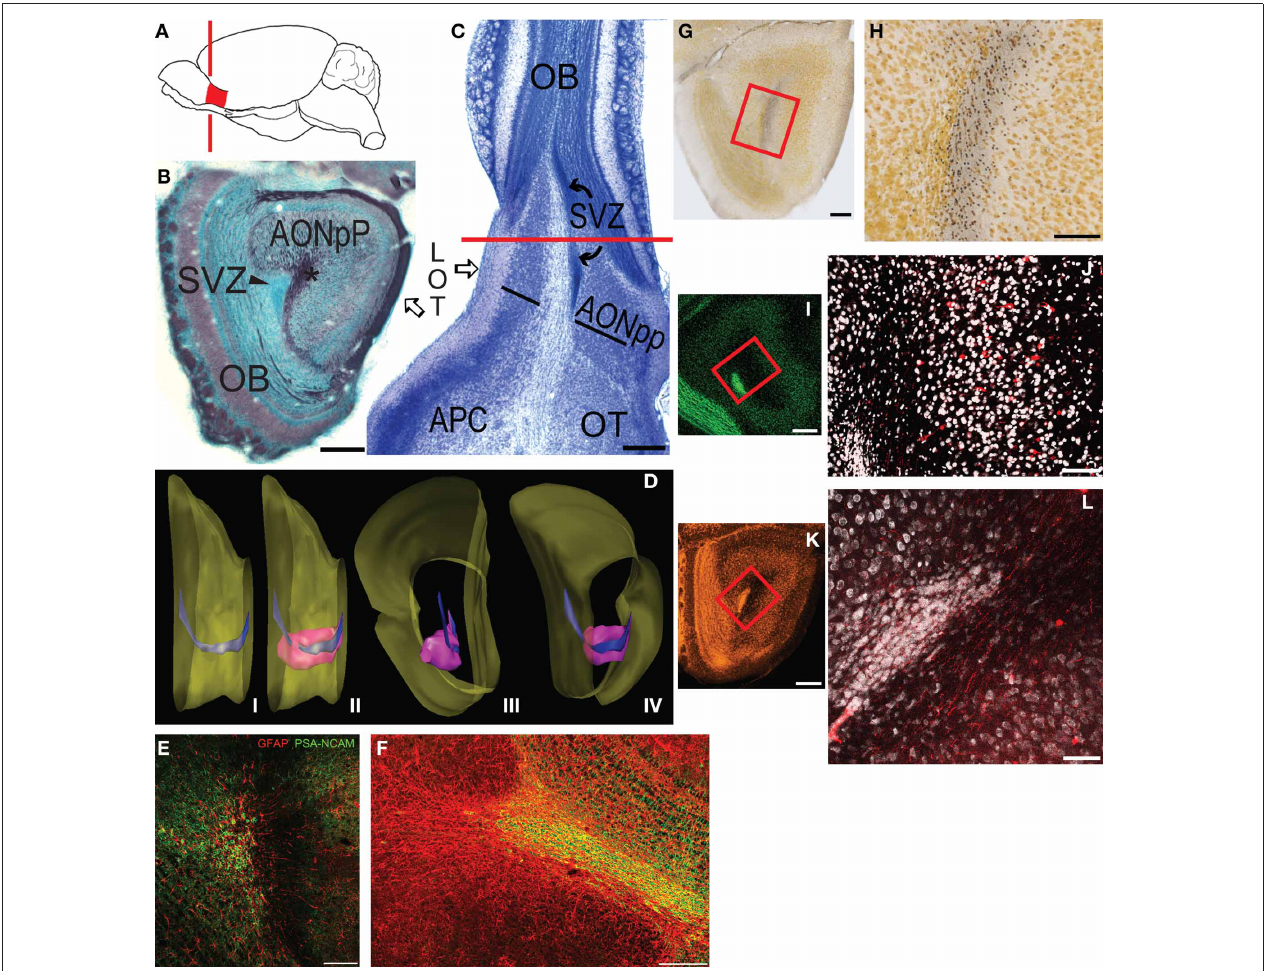
FIGURE 1 | (A) Diagram depicting the location of the mouse olfactory peduncle (red). Red line indicates the approximate location of the coronal section in panel (B) . (B) Coronal Nissl- (blue) and myelin- (black) stained section through the peduncle; medial to left, dorsal at top. (C) Horizontal Nissl section through peduncle; lateral to left, rostral at top. Red line is the approximate plane of section in panel (B) . Abbreviations: AONpP, pars principalis of the anterior olfactory nucleus; APC, anterior piriform cortex; LOT, lateral olfactory tract; SVZ, subventricular zone (rostral migratory stream); OB, olfactory bulb; OT, olfactory tubercle. Asterisk in (B) = anterior limb of the anterior commissure. In (C) the AONpP is found on both the lateral and medial side of the ALAC, the white matter region between the two black lines. (D) Diagram depicting the SVZ in the peduncle. (i) Medial view of the mouse forebrain; dorsal to top, anterior to right. Surface of the brain is yellow. Most of the OB has been removed from right side. The SVZ (blue) descends from the lateral ventricle at the left of the figure, and extends through the peduncle to